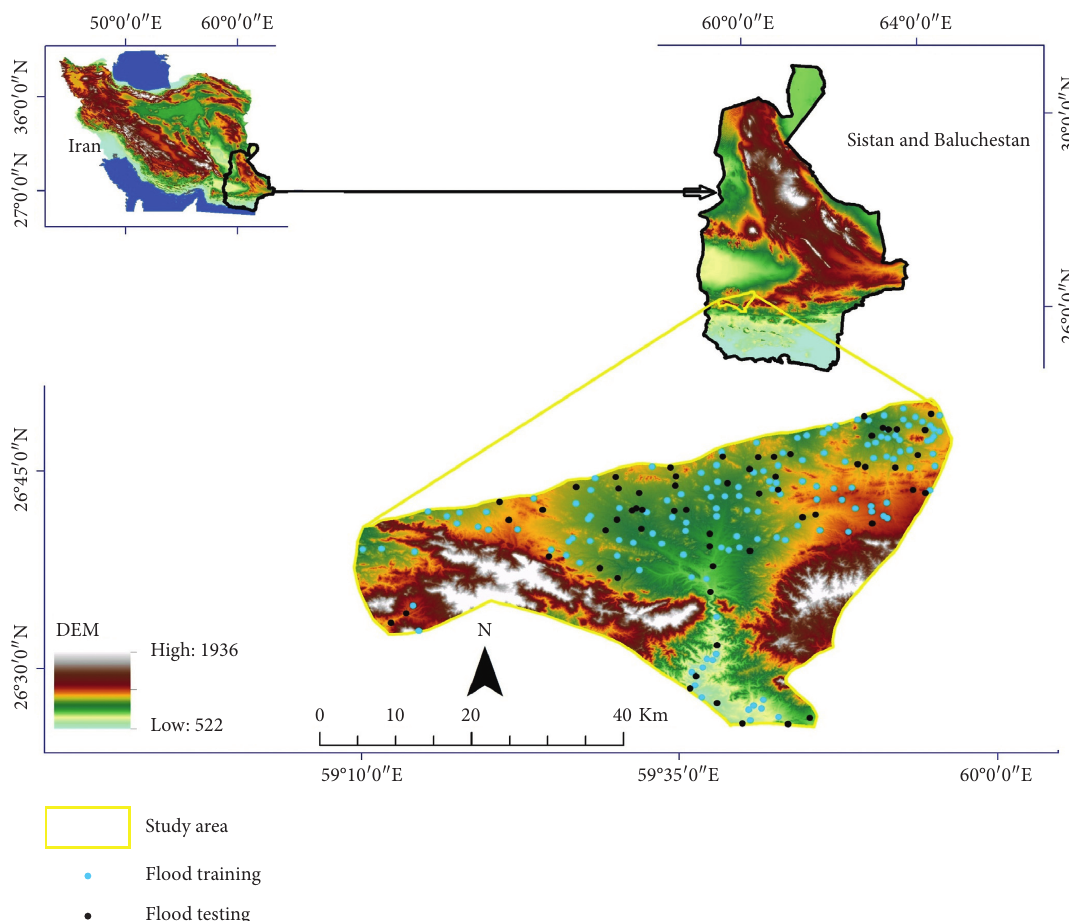
Figure 1: Location of the study